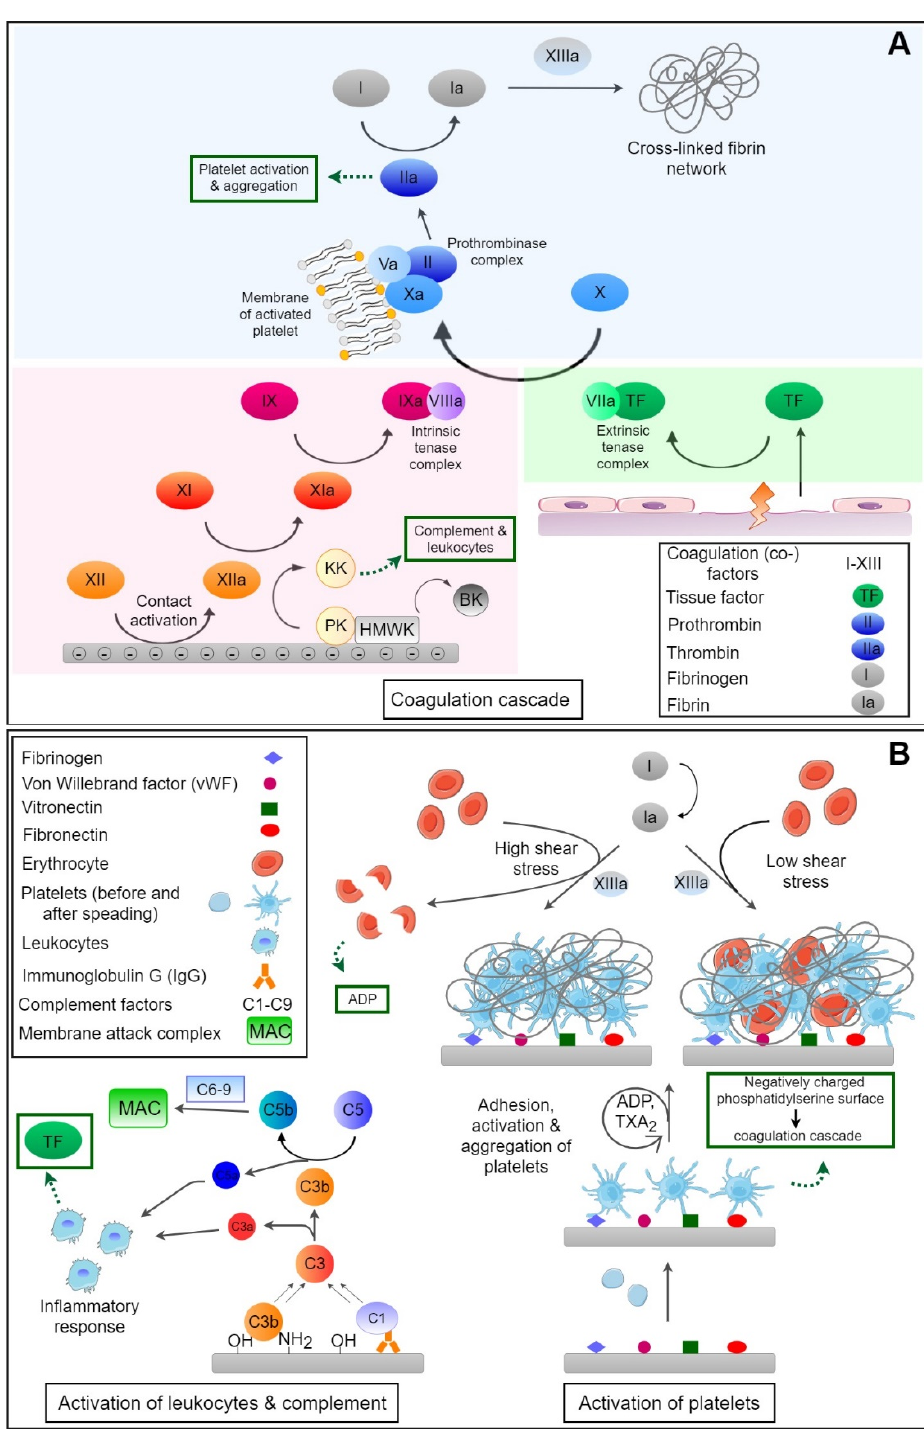
Figure 1. ( A ) Activation of coagulation by the intrinsic system through autoactivation of factor XII (FXIIa) with amplification by kallikrein (KK) and the extrinsic system after injuries through tissue factor (TF) leading both to activation of factor X (FXa). This is a component of a prothrombinase complex formed on the cell membrane of activated platelets exposing phosphatidylserine. KK also splits high-molecular-weight kininogen leading to release of vasoactive bradykinin (BK). Thrombin (FIIa) causes activation of fibrinogen leading to fibrin polymerization which is cross-linked by factor XIIIa. Thrombin is also the strongest agonist of platelets leading to their activation and aggregation. ( B ) Activation of complement system by covalent reaction of complement factor C3b with nucleo- philic groups on material surfaces (e.g., OH), bound antibodies, and immune complexes through factor C1q with generation of C3 and C5 convertase and release of anaphylotoxins C3a and C5a with activation of leukocytes, as well as the release of TF connecting complement with coagulation. As